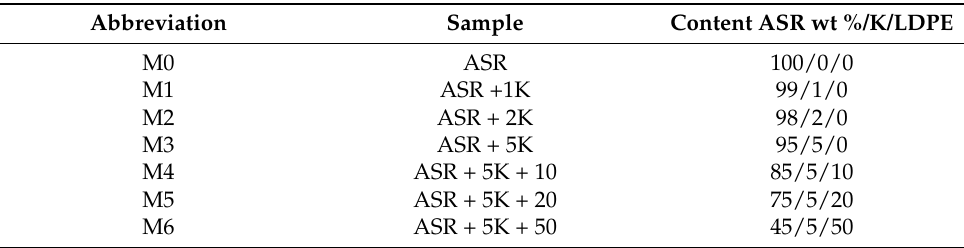
Table 1. Sample symbols and the percentage amount of ASR composite components.